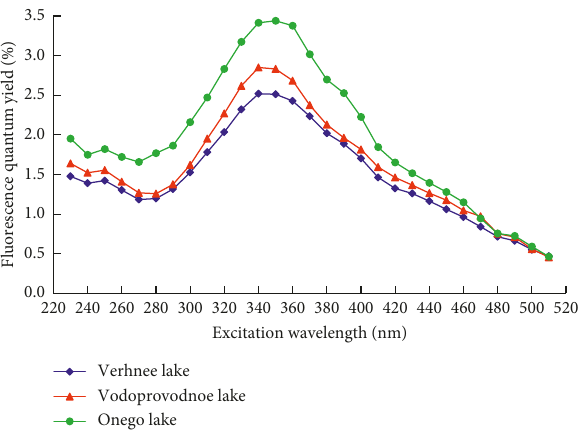
Figure 4: Fluorescence quantum yield as a function of excitation wavelength for CDOM samples from different Karelian